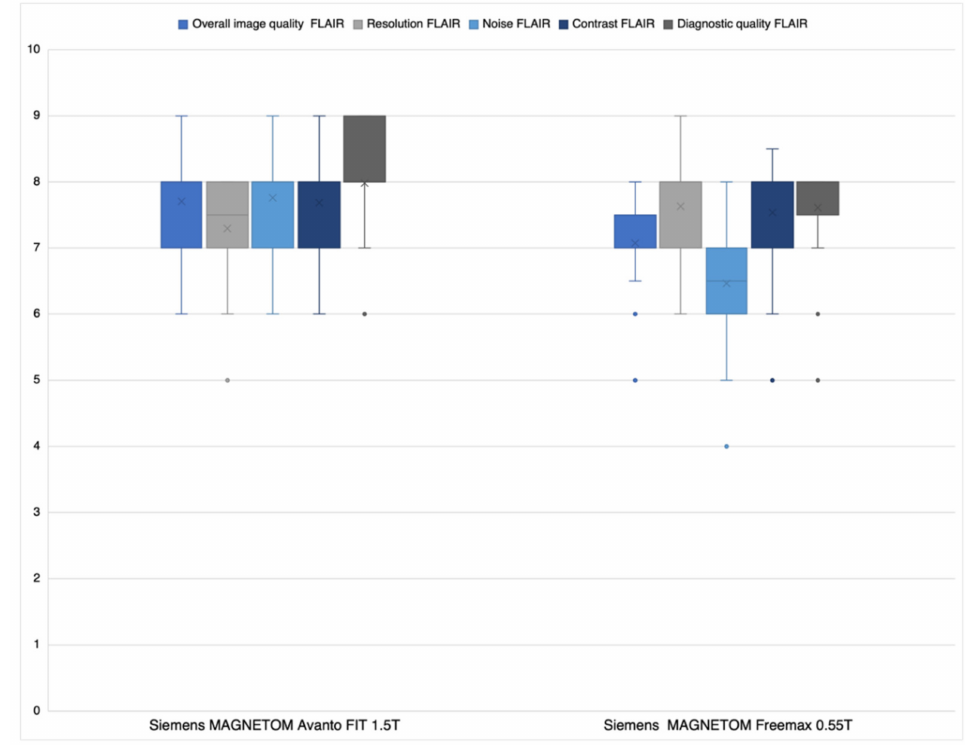
Figure 4. Average Likert-scoring reader 1 and 2 FLAIR